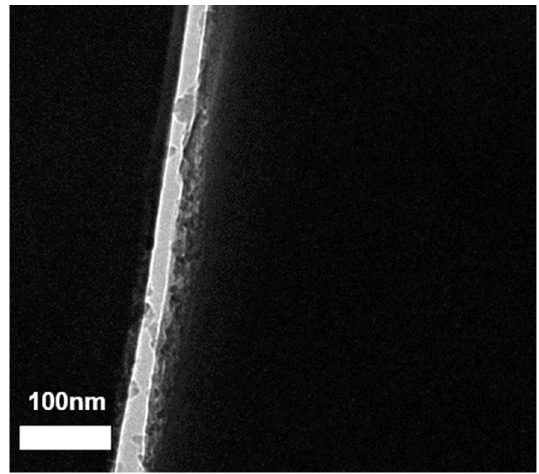
Figure 8. Cryo-TEM of single MWCNT/PANI/Ag + .